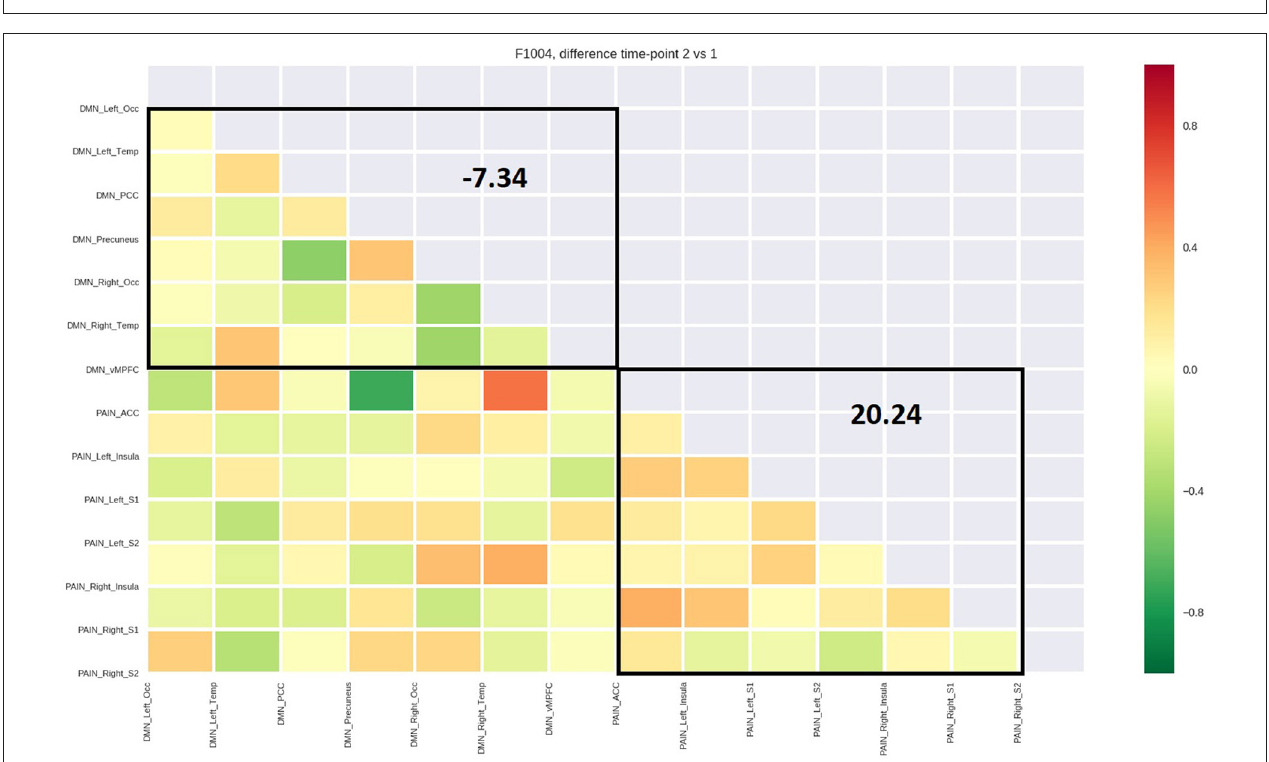
FIGURE 3 | Matrix difference T2–T1 of the second patient and DMN and PN average connectivity.